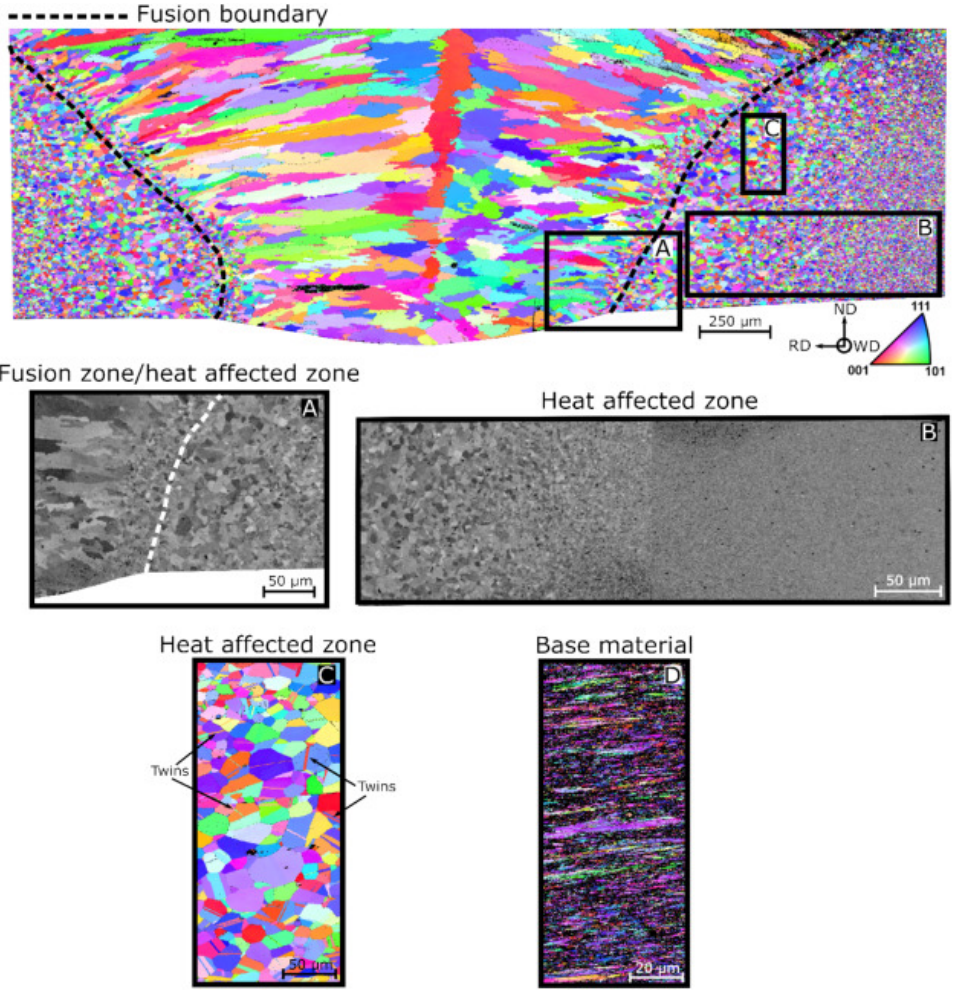
Figure 3. EBSD analysis of the CrMnFeCoNi HEA weld joint: (A) the fusion line, (B) the HAZ, (C) the HAZ containing twins, (D) the BM. Reproduced with permission from [78]. Copyright